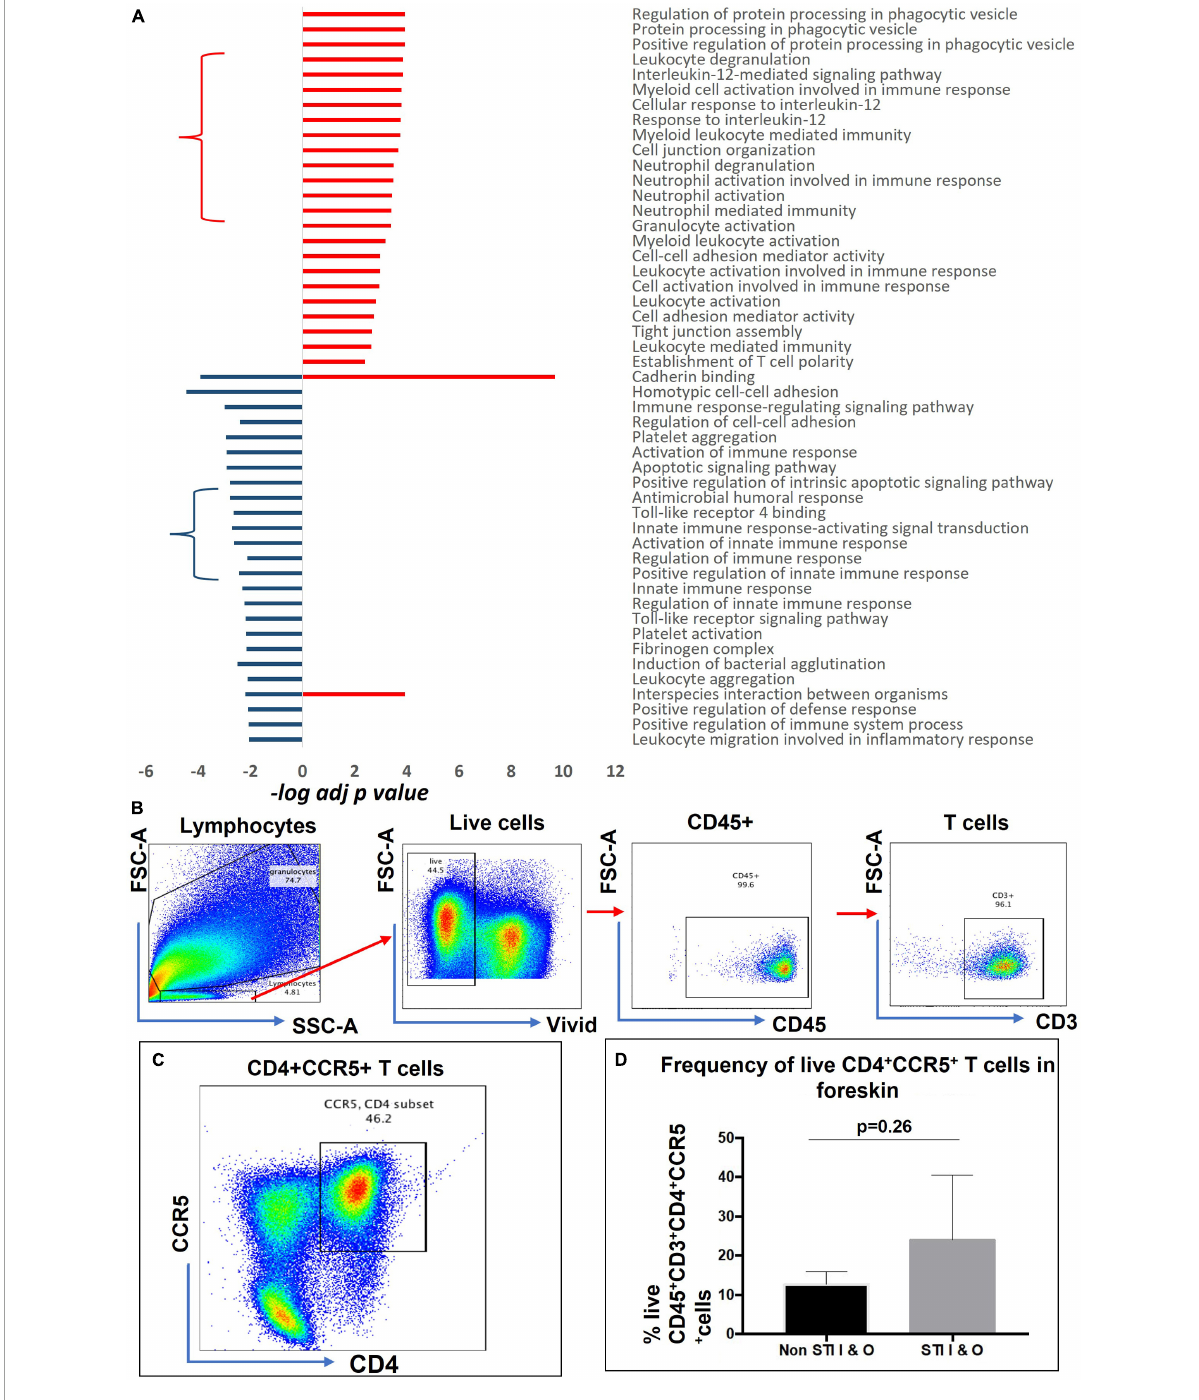
FIGURE3 Distinct functions enriched from proteins upregulated in aSTI foreskins and age-matched controls. (A) Significance of immune-related GO term enrichment in aSTI + (red bars) and aSTI- (blue bars) foreskin proteomes. A classical enrichment analysis tested (Fischer’s test) the significance of enrichment of the GO terms in the respective proteomes and is expressed as logarithms. (B) Multiparameter flow cytometry gating strategy applied to phenotype-isolated primary inner and outer foreskin leukocytes expressing CD3. Live cells were selected which expressed CD45 and CD3 as shown. (C) A representative bivariate flow cytometry plot showing single- and double-positive CD4 + CCR5 + cells gated from CD45 + CD3 + T cells. The boxed gate shows the percentage of double-positive T cells. (D) Percentage of CD45 + CD3 + CD4 + CCR5 + cells from combined outer and inner foreskins in STI- controls and STI + men. Error bars represent the standard deviation from the mean. The cells were gated from the grandparent (CD45 + CD3 +